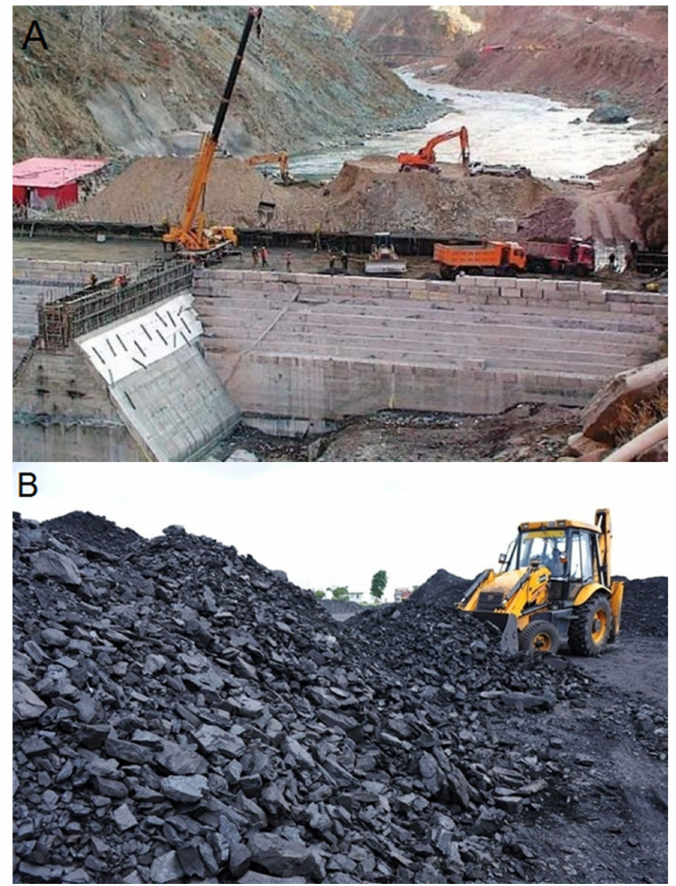
Figure 7. ( A ) Desu hydropower project along the Indus River, ( B ) Pothwar coal mining in the upper Indus